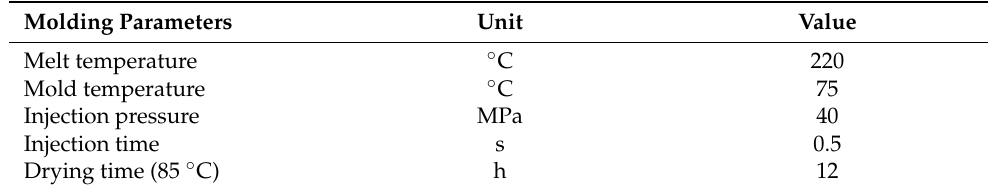
Table 1. Molding